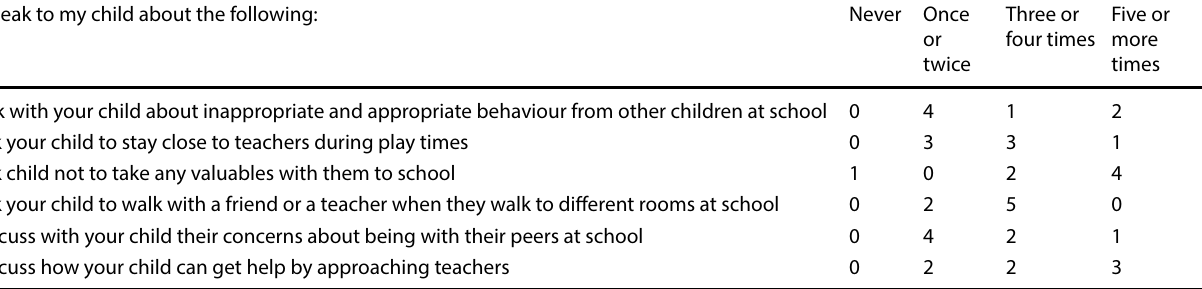
Table 2 Parents’ support their children about bullying at